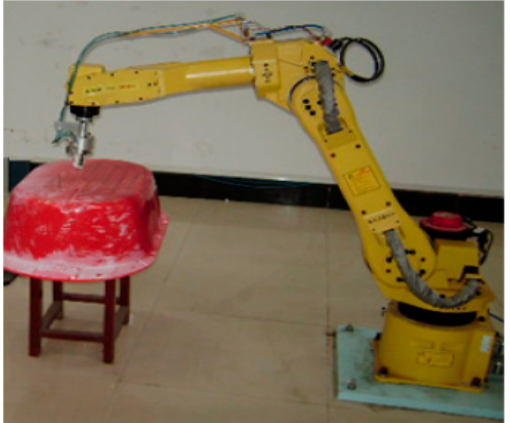
Figure 13. Spray painting Experiment in the Laboratory.